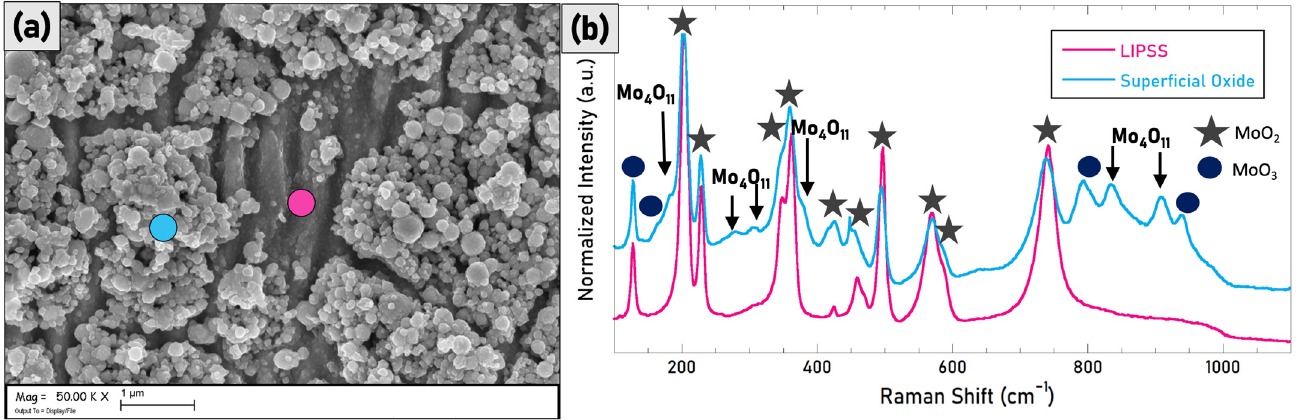
Figure 16. In ( a ), the SEM image of the S4 sample in which the difference between the underneath LIPSSs (pink point) and the upper nanostructures (blue point) is clearly visible. In ( b ), Raman spectra have been acquired at the same points indicated in the micrograph.